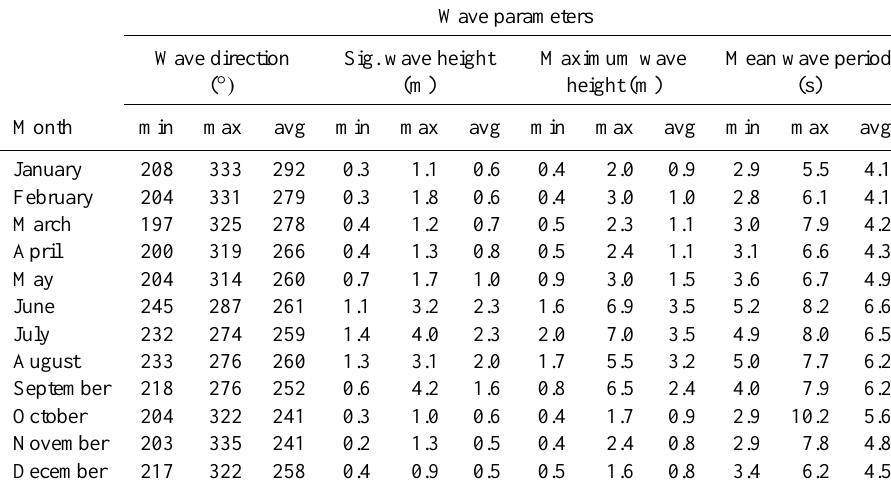
Table 3. Monthly variation of sea state variables in 2011.